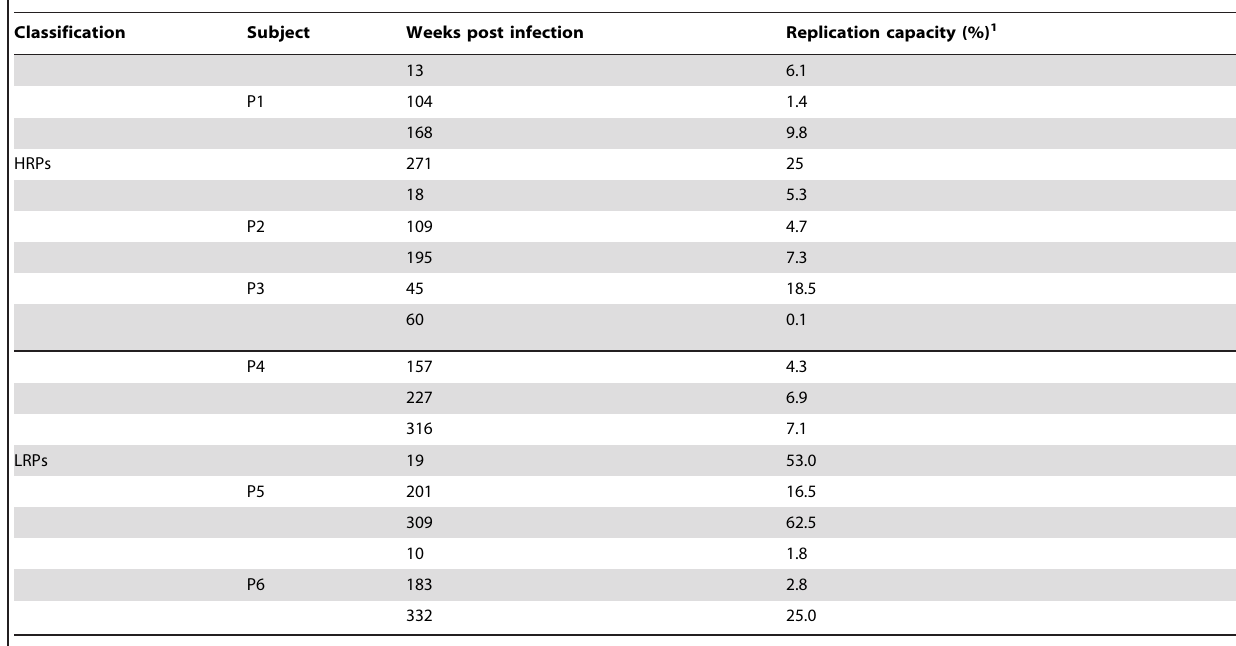
Table 2. Replication capacity in six HLA-B*5701 subjects.